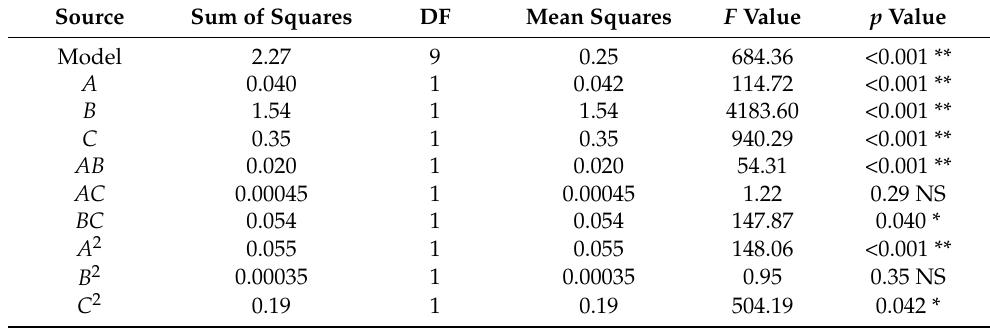
Table 7. Regression variance analysis of damage